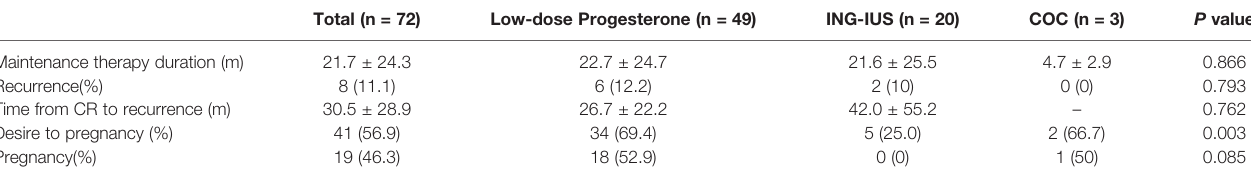
TABLE 4 | Recurrence rate of patients with different maintenance therapy regime after achieving complete